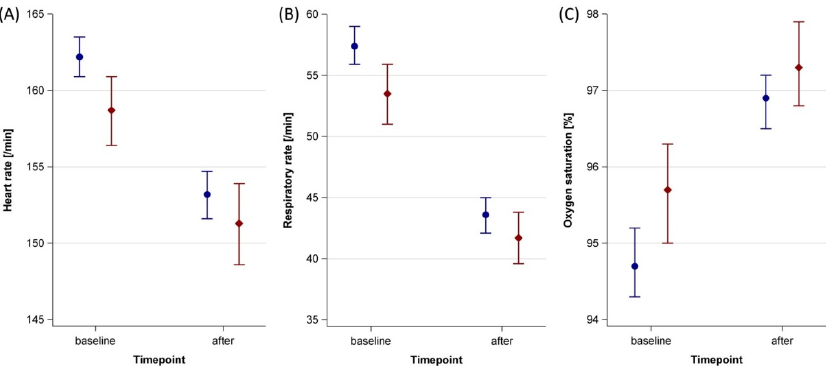
Figure 2. Baseline and post-therapy vital sign values in 40 stable preterm infants receiving music therapy with and without physical contact at the University Hospital Essen between October 2018 and July 2021. Blue = no physical contact (159 sessions); red = with physical contact (444 sessions); error bars = 95 % confidence intervals. ( A ) Heart rate. ( B ) Respiratory rate. ( C ) Oxygen saturation.